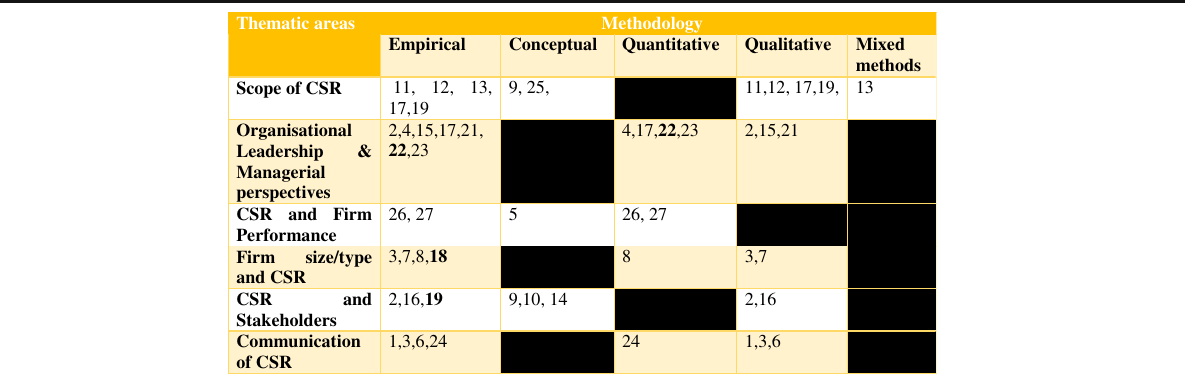
Table 1 Methodological distribution